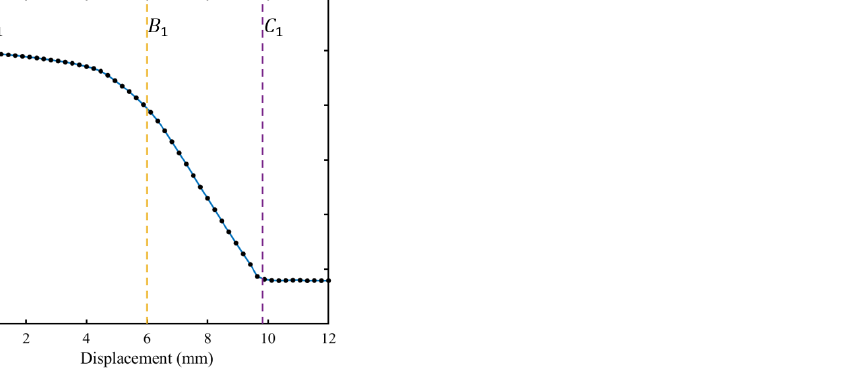
Figure 23. Comparison of the VCSB fractures between effective stress contour plots of FEM-0 and Test 1.